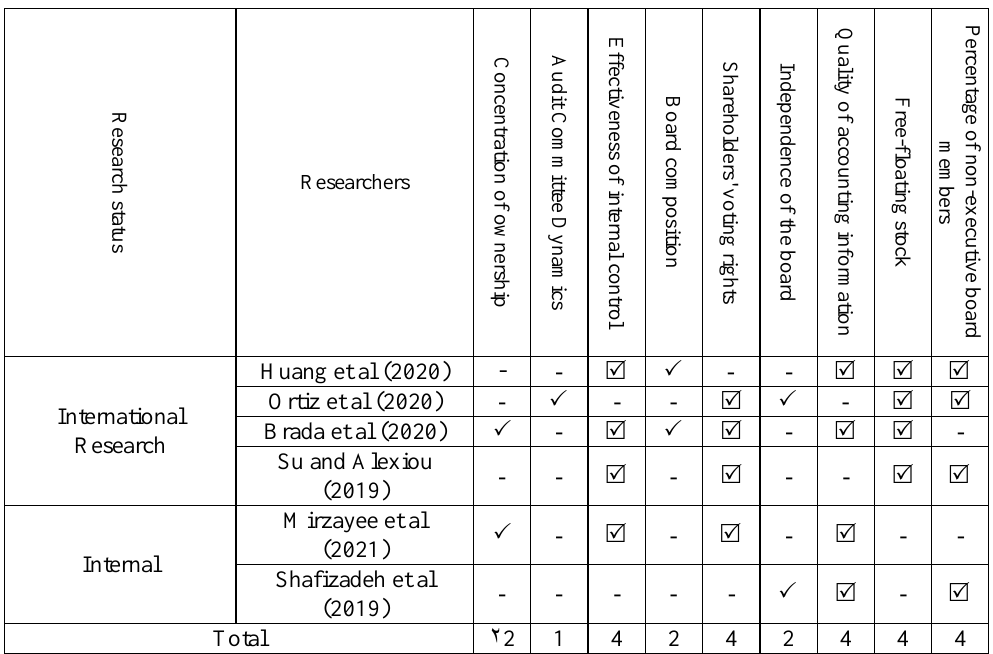
Table 3. the process of determining the main components of